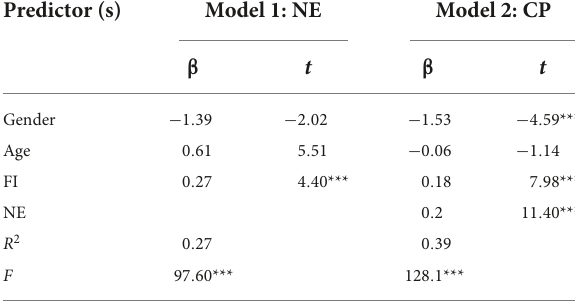
TABLE 2 Testing the mediation effect of negative emotions on cyberbullying perpetration ( N = 814). Predictor (s)